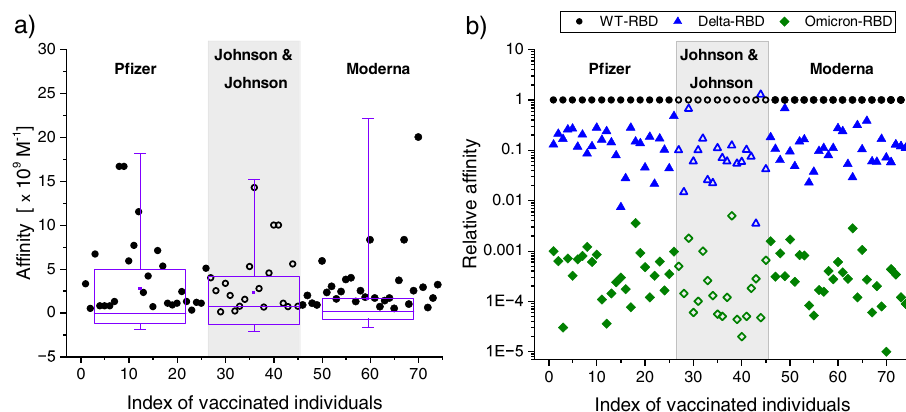
Fig. 2 Anti – SARS-CoV-2 WT-RBD af fi nities and relative af fi nities toward variants. a All af fi nities of patient anti-spike antibodies to WT-RBD are simply plotted against an index of the vaccinated individuals, grouped by vaccine make. All three vaccines induce similar, high-af fi nity antibodies toward WT-RBD. There is no signi fi cant difference in af fi nity among the three vaccine groups (F-test p -value = 0.7051). b Relative antibody af fi nities of individual patients to RBD variants (Delta, Omicron) as compared to WT-RBD (normalized to 1). As before, these relative af fi nities are plotted against patient index. The results show a remarkably consistent trend (no signi fi cant difference among the three vaccine groups, F-test p -value = 0.9018). All vaccine-induced antibodies have approximately a 10-fold weaker af fi nity toward Delta-RBD and a 1000-fold weaker af fi nity toward Omicron-RBD. The differences in relative af fi nities toward the variants are statistically signi fi cant (F-test p -value = 0.0000). The number of samples tested was 26, 19, and 29 for P fi zer, Johnson & Johnson, and Moderna,